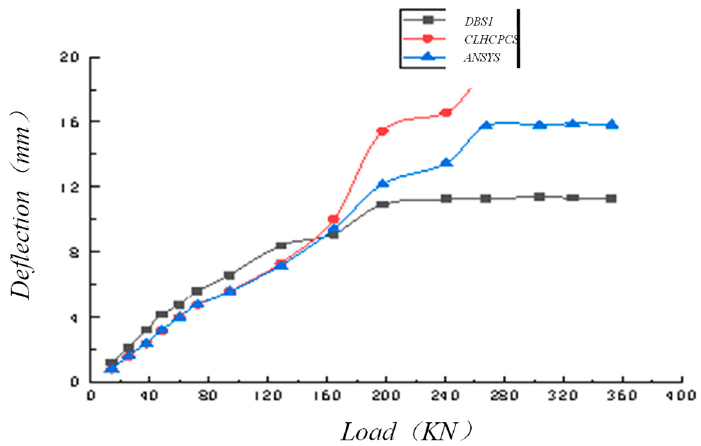
Figure 38. CLHCPCS and ordinary composite slab load − deflection curve.